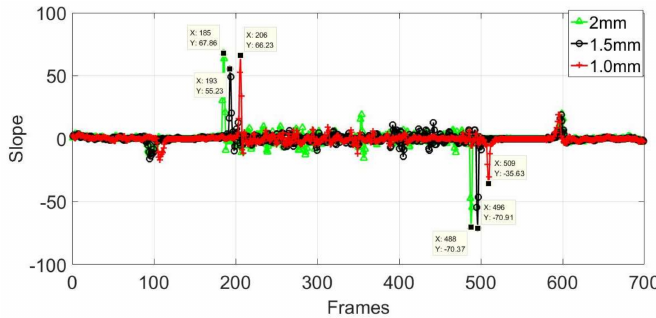
Figure 16. Slope of first derivation of three different